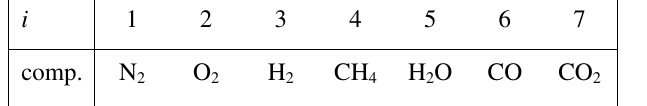
Table 1. Reactions at anode and cathode At anode